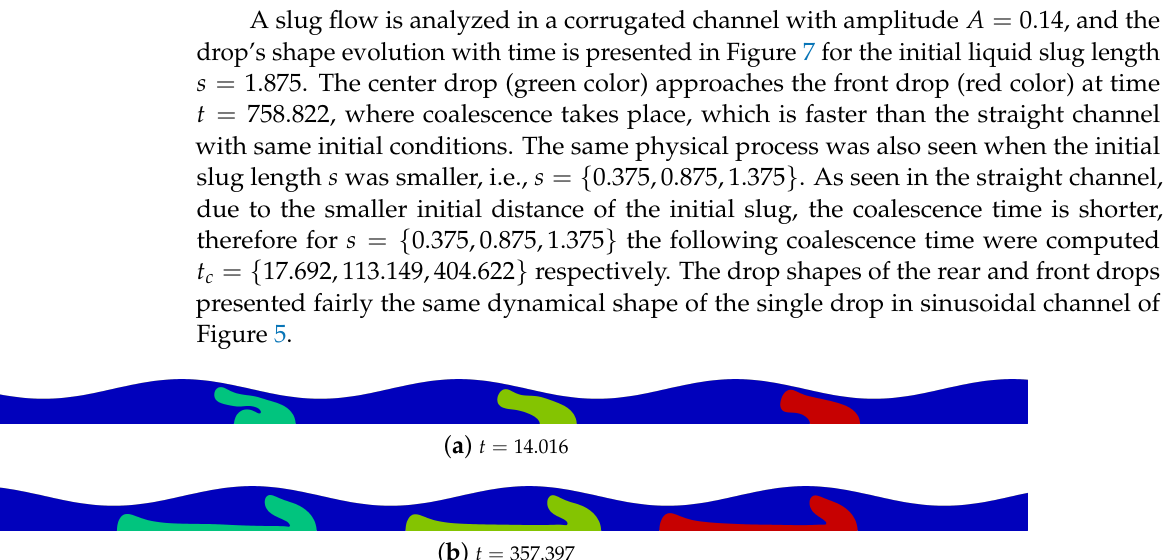
Figure 6. Drops shape evolution with time in straight channel with amplitude A = 0.00 and initial liquid slug length s = 1.875. The rear drop is green color, the center drop is yellow and the front drop is red. The center drop is hydrodynami- cally affected by the presence of the front and rear drops, thus simulating a complex slug flow. Drop’s coalescence is noted between the front and center drops in time t c = 908.634. All parameters are dimensionless.